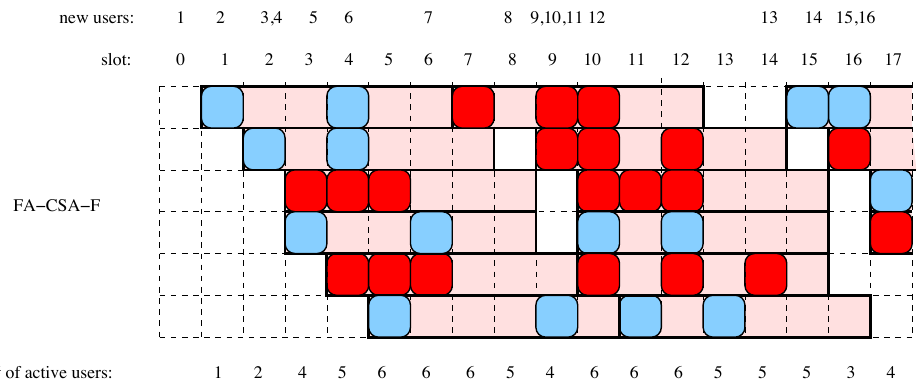
Figure 3. An example of FA-CSA-F with k =